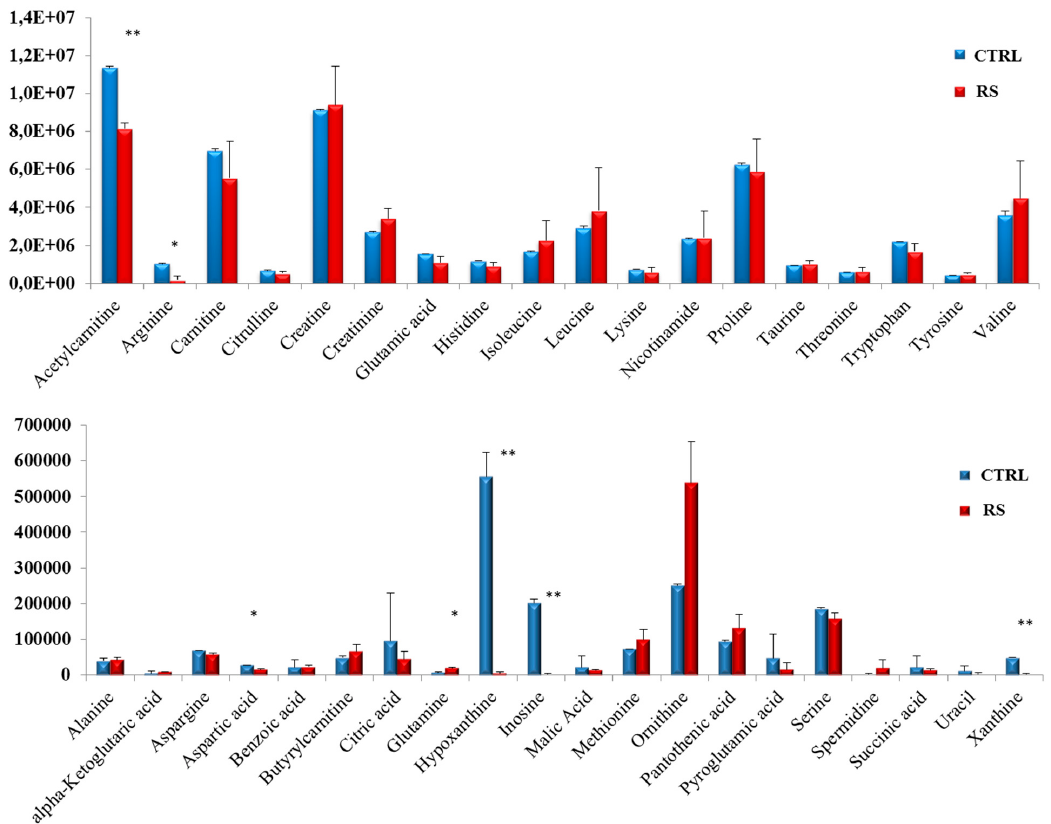
Figure 6. Bar chart representation of the 38 metabolites detected in the control and the RS-fed mice serum samples. Results are expressed as means ± standard deviation (SD). Differences were considered significant when p < 0.05 (*) or p < 0.01 (**).